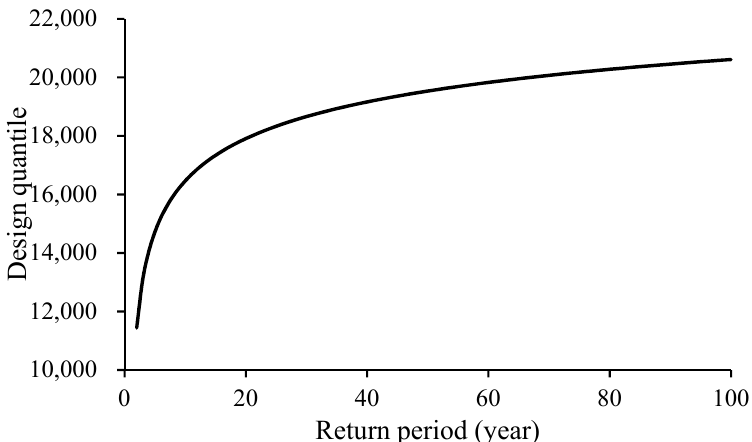
Figure 9. The design quantiles of different return periods of the Me-RS series in JRB.